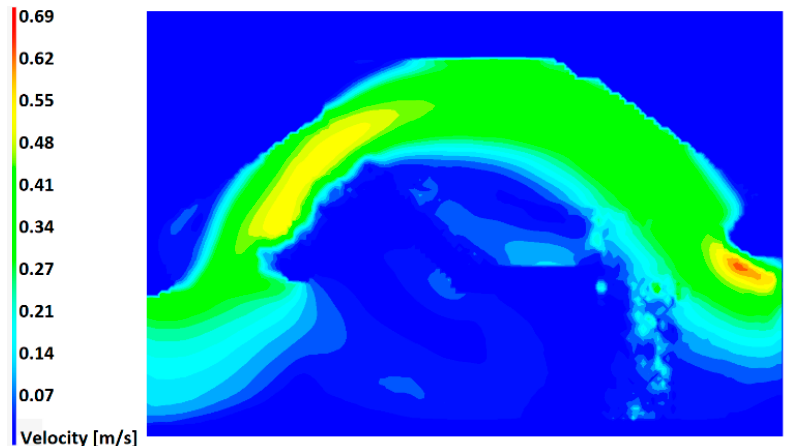
Figure 7. The velocity distribution based on the PIV from the second measurement area.